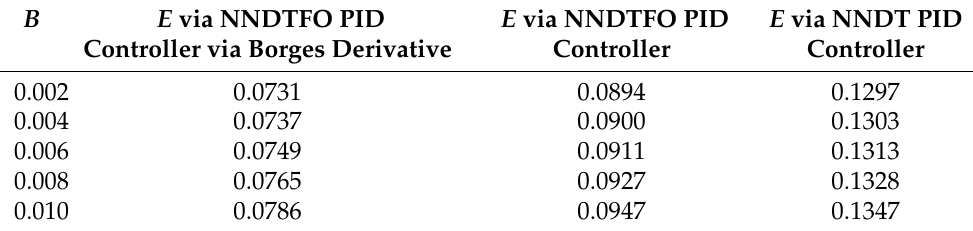
Table 3. Index E for different parameters B via three types of controller.